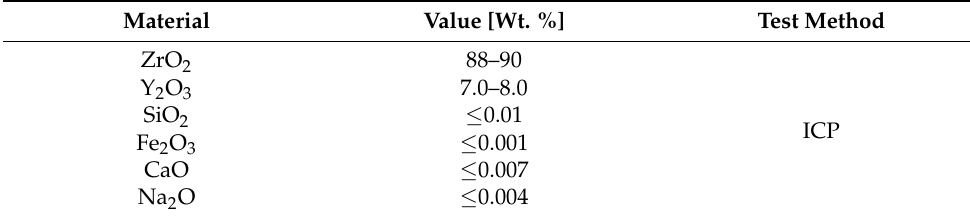
Table 2. Chemical composition of the zirconia block.